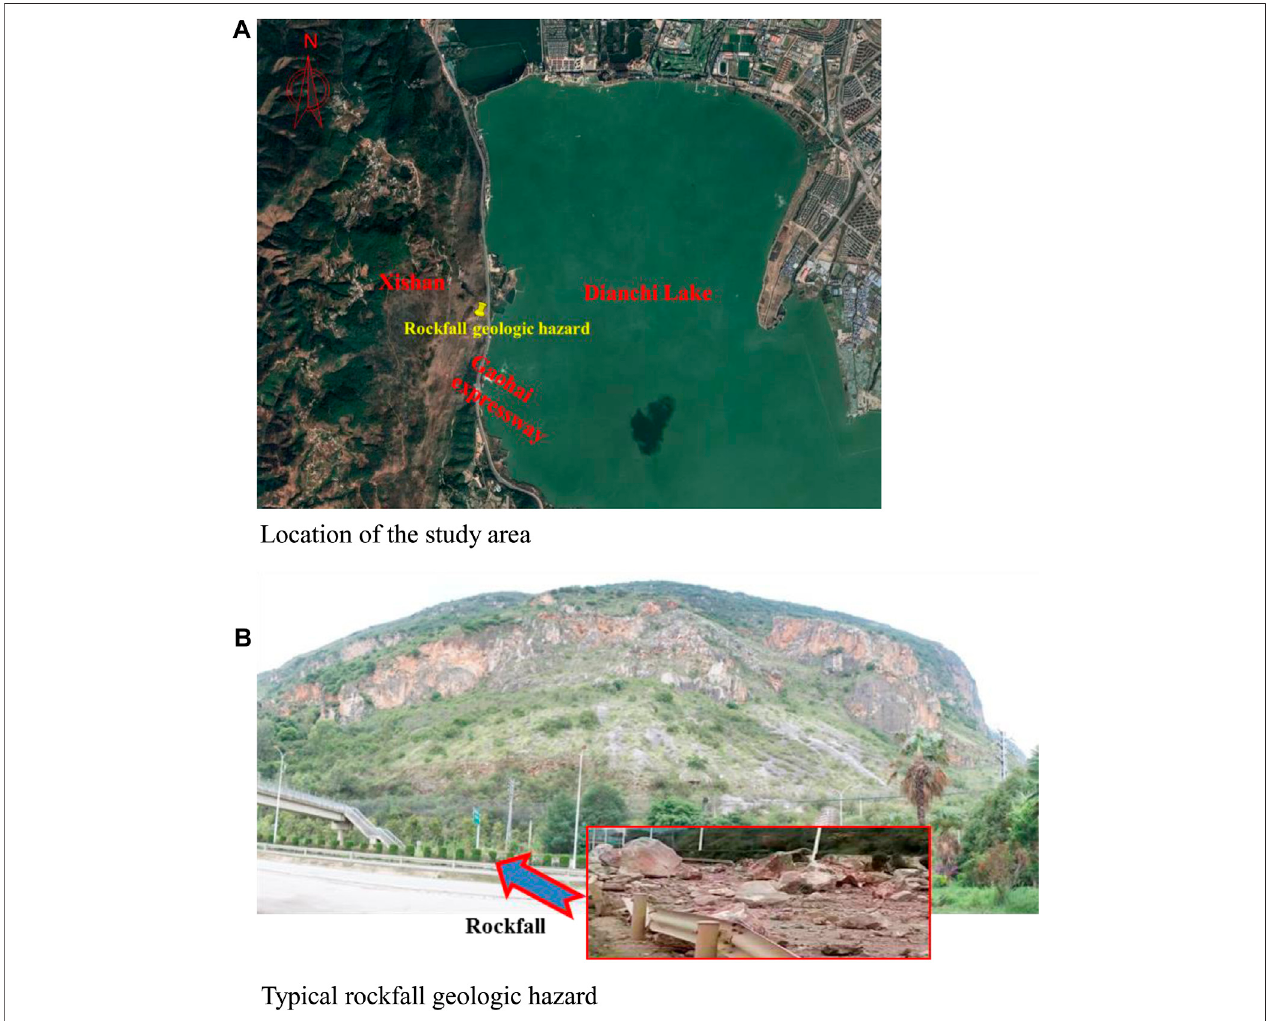
FIGURE 1 | (A) Location of the study area. (B) Typical rockfall geologic hazard location and photographs of the rockfall used as a case study.